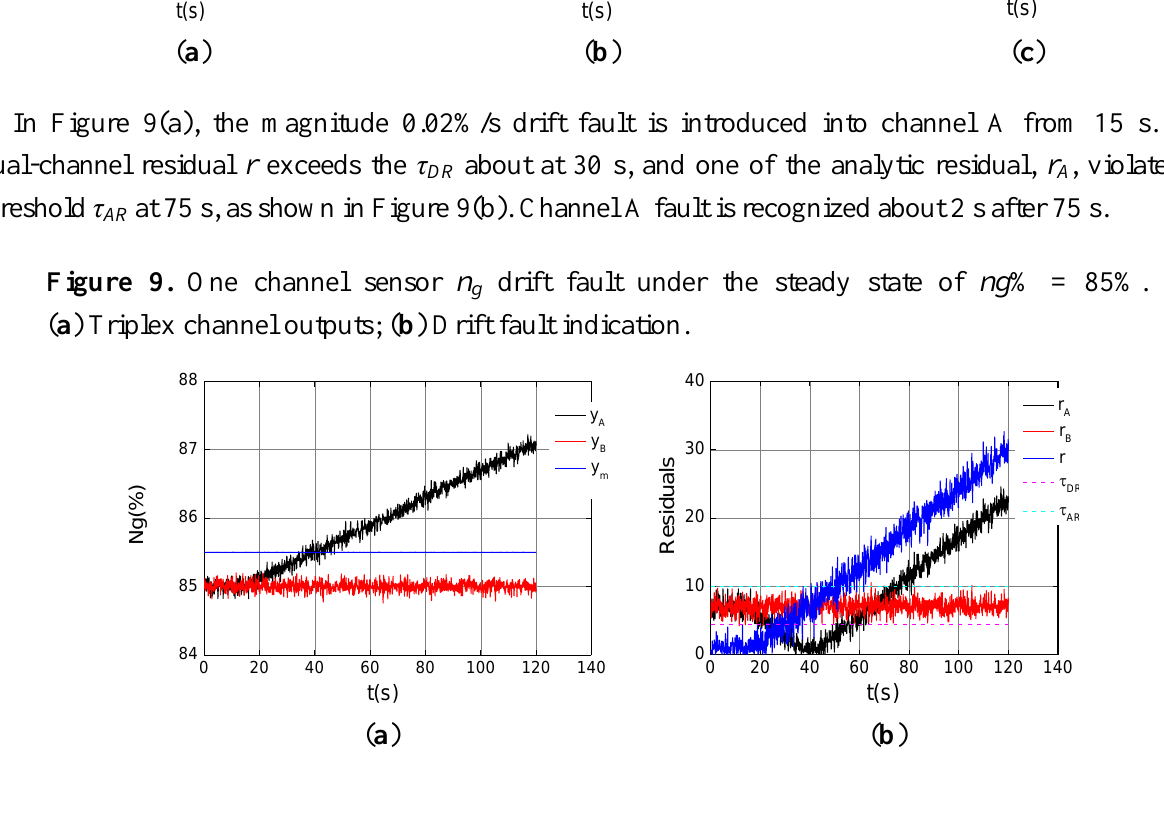
Figure 9. One channel sensor n